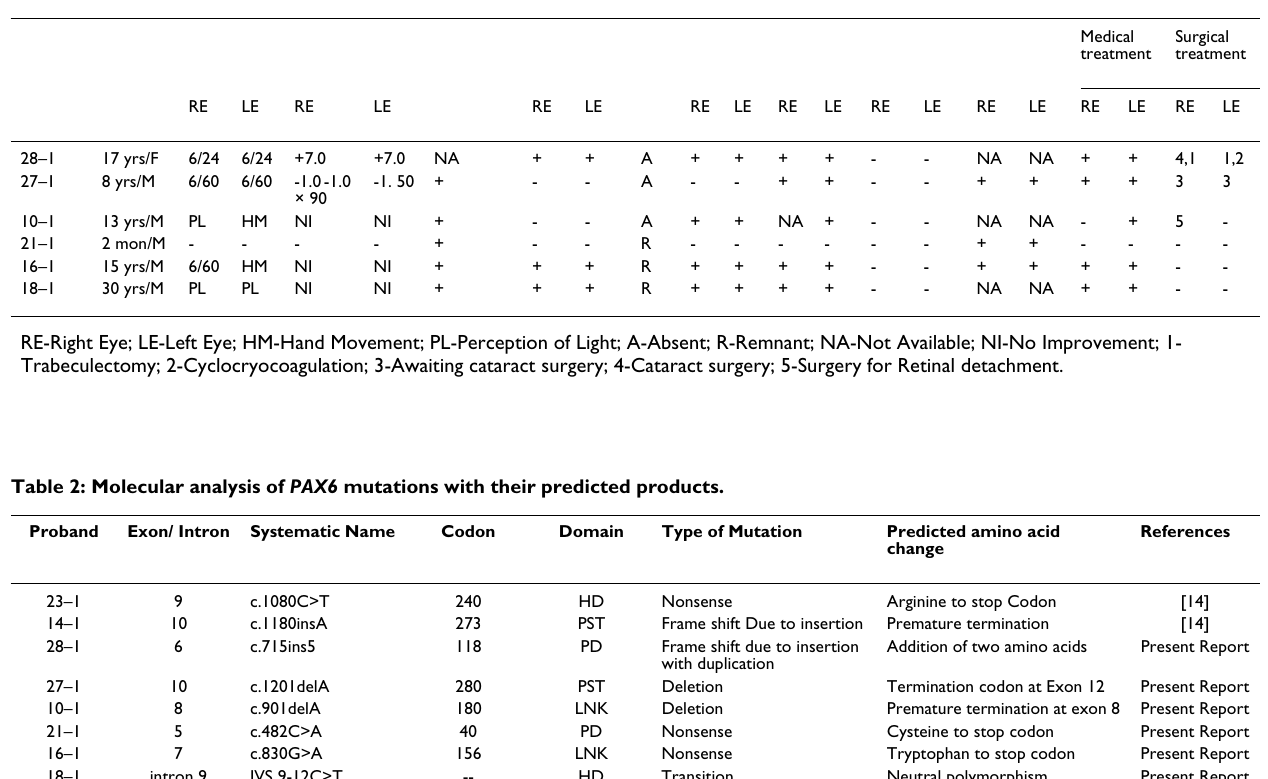
Table 1: Clinical and common phenotypes associated with the aniridic probands Proband Age/ Sex